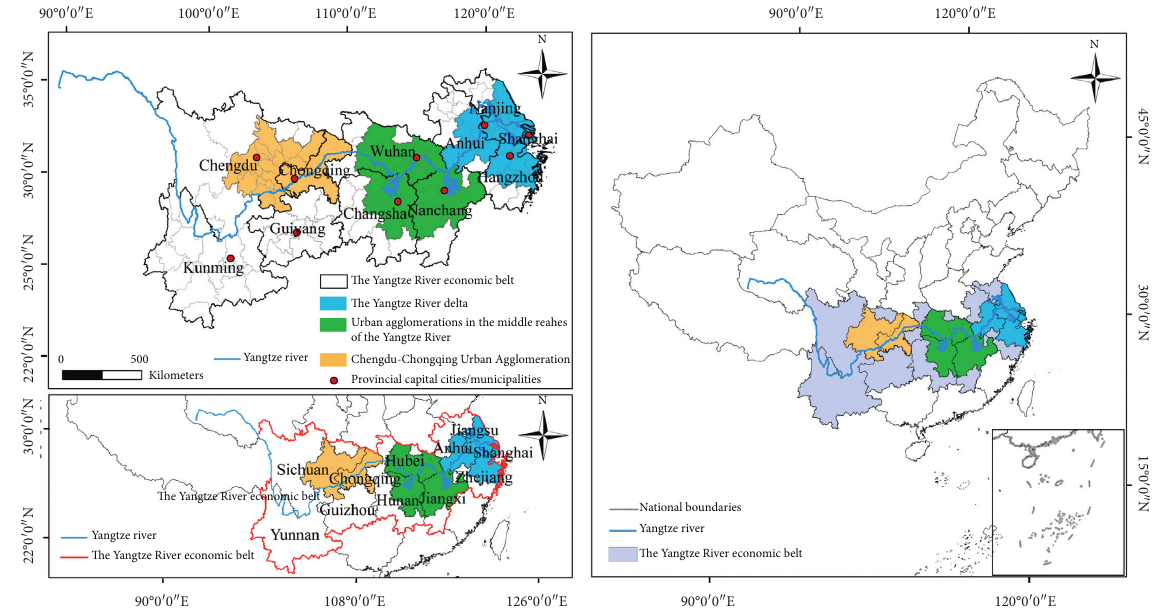
Figure 1: Geographical location map of the YEB